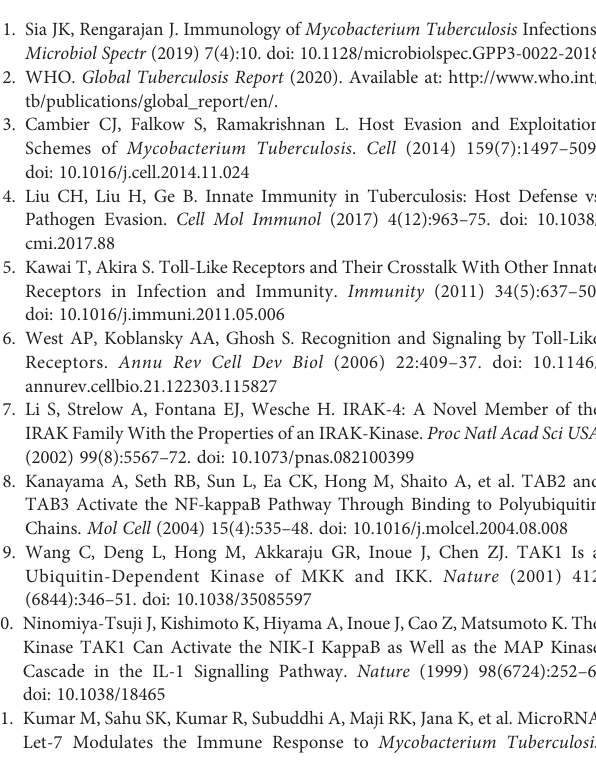
Table 1 and cloned into pCMV-Myc. (B) HEK293-TLR4 cells were transfected with 10 eukaryotic plasmid deletion mutants of Rv0927c, as well as plasmid NF- k B reporter and pRL-TK. After stimulation with LPS, cells were harvested to measure the luminescence. (C) HKE293-TLR4 cellswerepre-incubated withRv0927c (5 m g/ ml) for 2 h and then were treated with LPS for 0.25 h. The translocation of p65 was observed using fl uorescence microscope. Scale bars, 5 m m. * P < 0.05 and ** P < 0.01 (unpaired two-tailed Student ’ s t test). Data are representative of one experiment with two independent biological replicates (mean and sem of n = 3